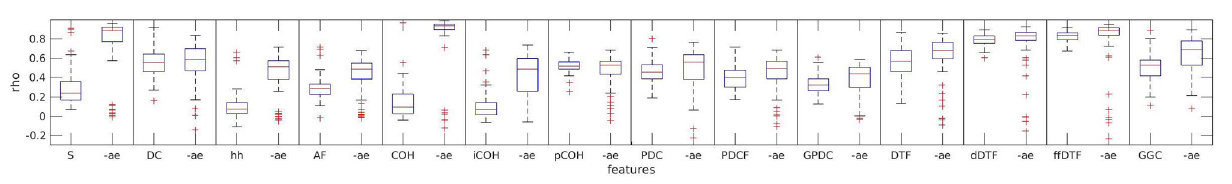
FIGURE 2 | Effect of artifacts and artifact exclusion on test-retest reliability of the assessed measures. For each measure two boxplots indicate the complete data and artifact-free data variant, respectively. “-ae” indicates the boxplot of the respective measure when artifacts were excluded. S, spectrum; DC, direct dausality; hh, transfer function polynomial; AF, transfer function; COH, real valued coherence; iCOH, imaginary part of complex valued coherence; pCOH2, partial coherence; PDC, partial directed coherence; PDCF, partial directed coherence factor; GPDC, generalized partial directed coherence; DTF, directed transfer function; dDTF, direct